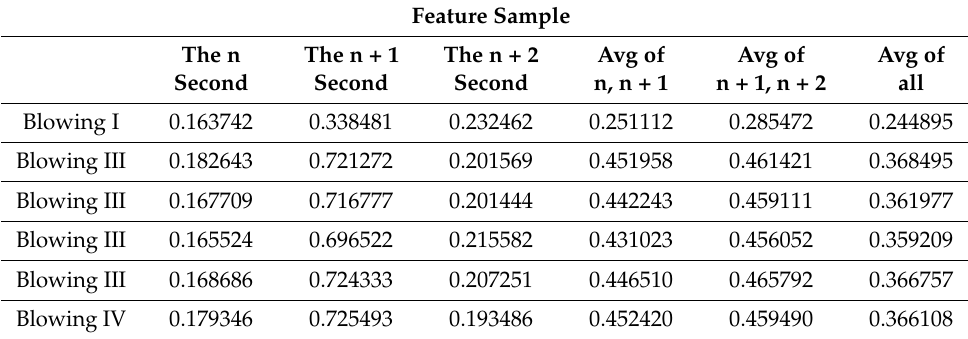
Table 5. Blowing III is the result.